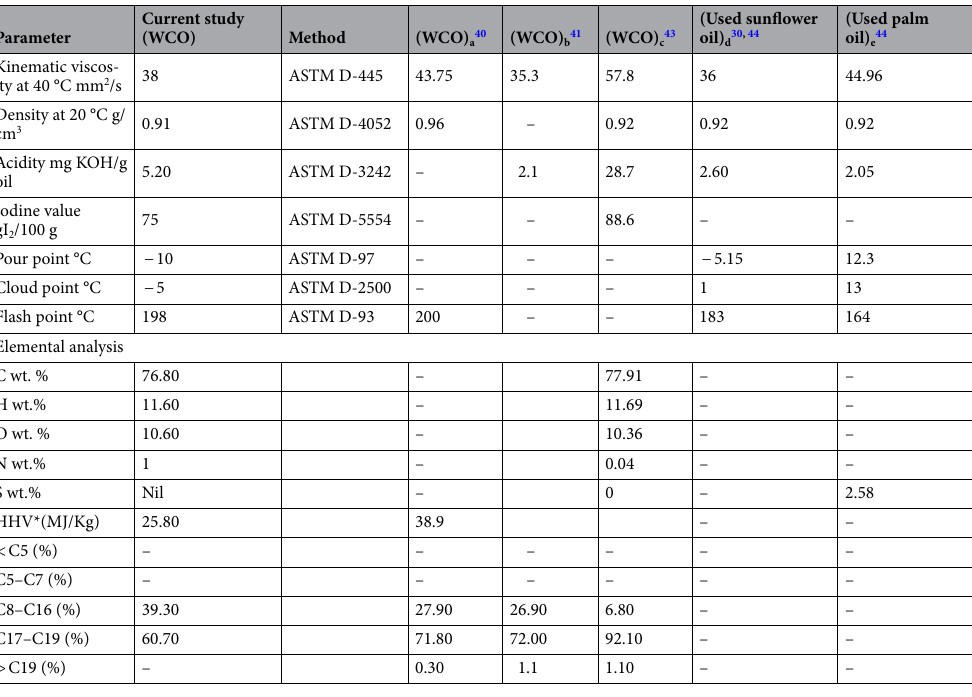
Table 1. Basic properties of this work WCO* and other referenced feedstocks. HHV * High heating